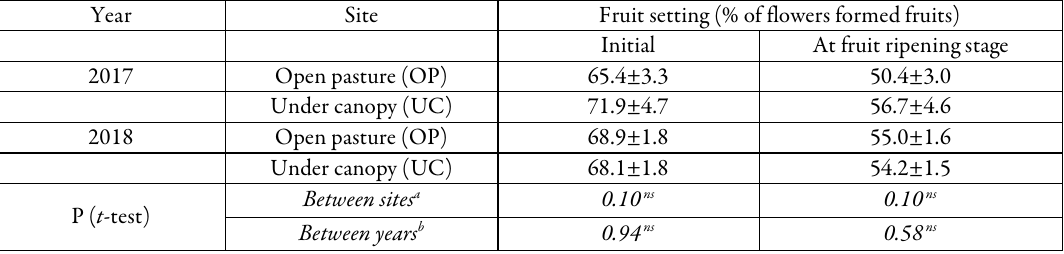
Table 1. Fruit setting (% of flowers formed fruits) of P. crenulata in two sites, over two years of